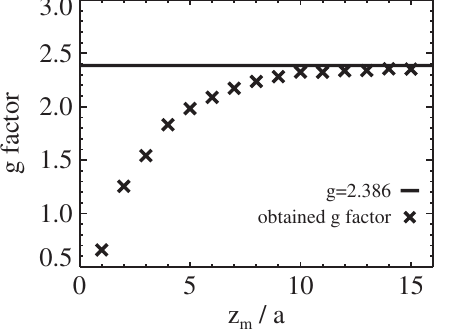
FIG. 2. The g factor obtained from the numerical electric field (crosses) as a function of the bunch length. It can be seen that the approximation of a constant g factor (solid line) applies for =a * 10 z m